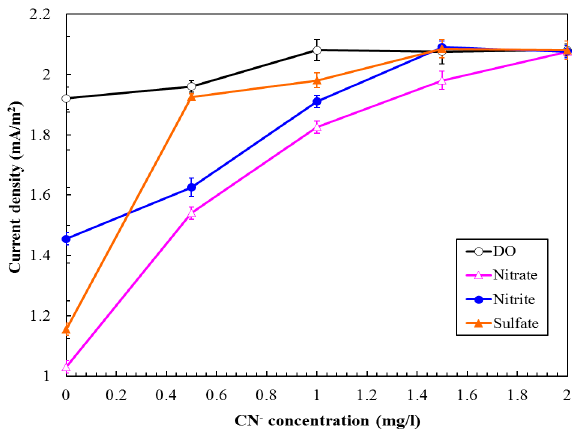
Figure 6. Effect of cyanide concentration in the influent on the MFC performance. (GGA concentration: 100 mg/L as BOD 5 ; oxygen gas concentration: 4.5 mg/L; nitrate concentration: 500 μ M; nitrite concentration: 700 μ M; sulfate concentration: 1000 μ M; LRT: 4 h; GRT: 6 min).